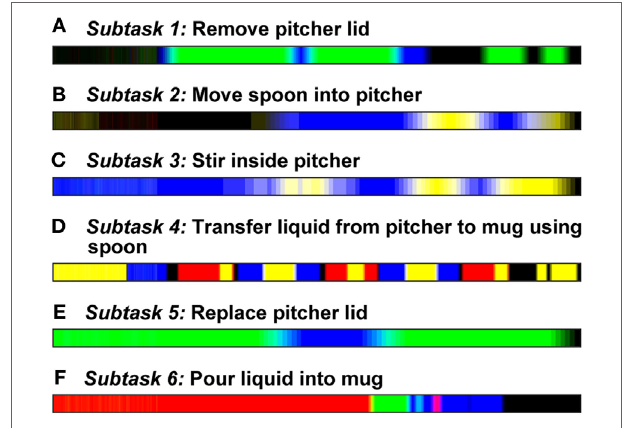
FigUre 7 | Characteristic gaze object sequences were produced using dynamic time warping barycenter averaging over data from 11 subjects for each of six subtasks (a–F) . The colors in the figure correspond to the color-coded objects in Figure 1c . The lengths of the sequences were normalized for